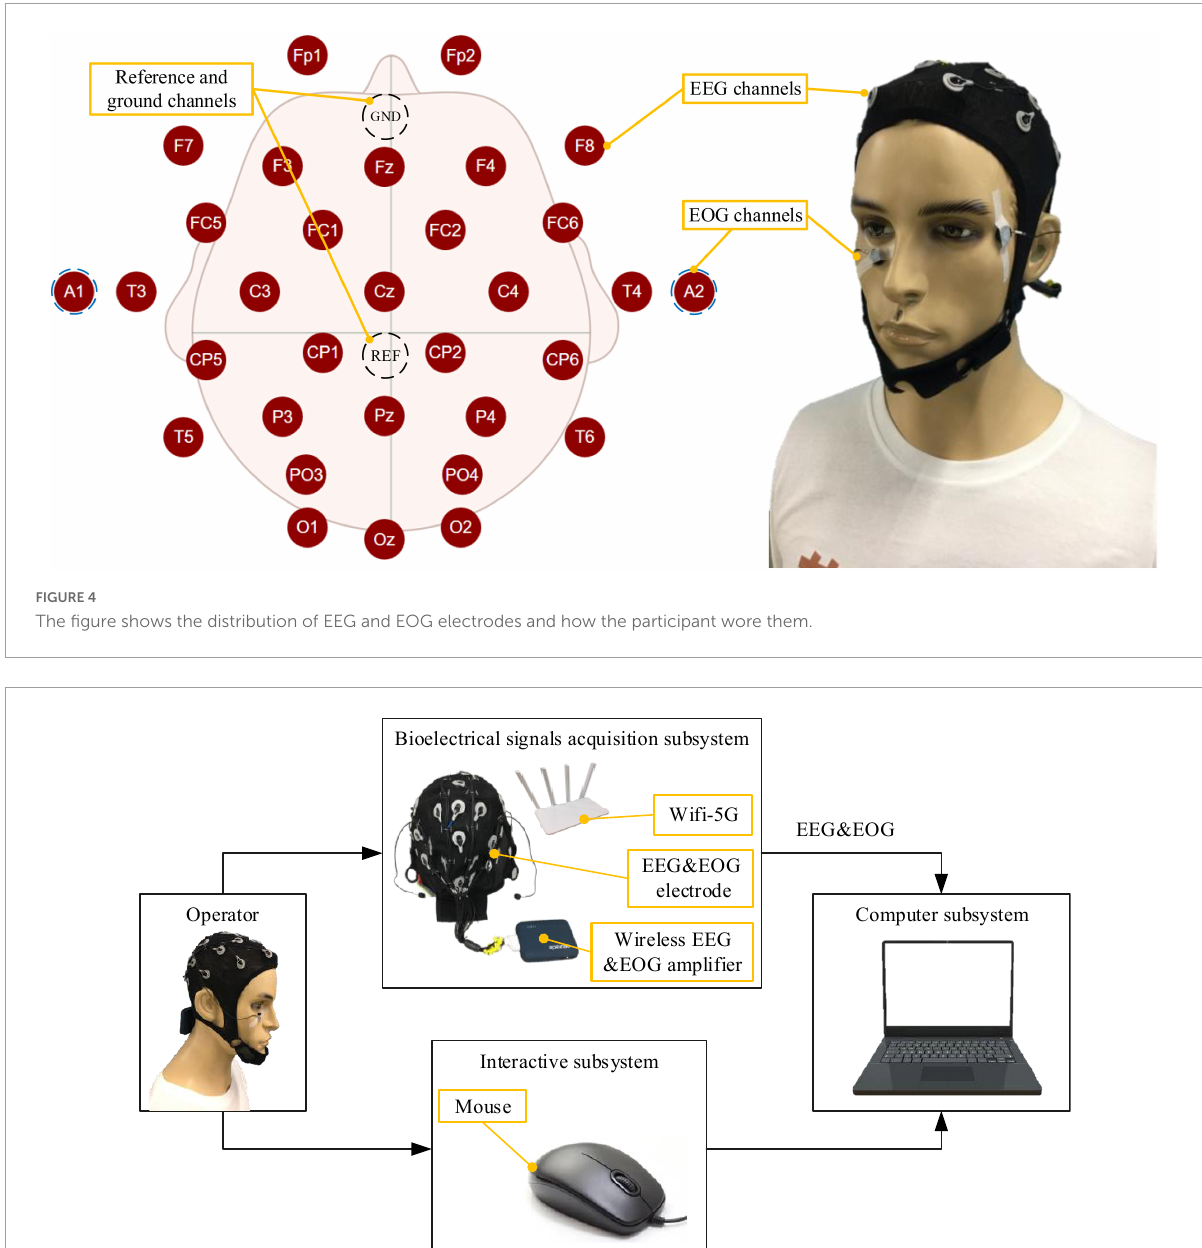
through the mouse, and the speed adjustment instructions were continuously adjusted by the CA in the PSA model according to the changes in the operator’s mental state. The robot combined the two instructions to perform the tasks. In the task, the operator continuously adjusted the control instruction by observing the robot’s running state. Meanwhile, the CA adjusts the robot’s speed adjustment instruction in real-time by detecting the mental state of the human